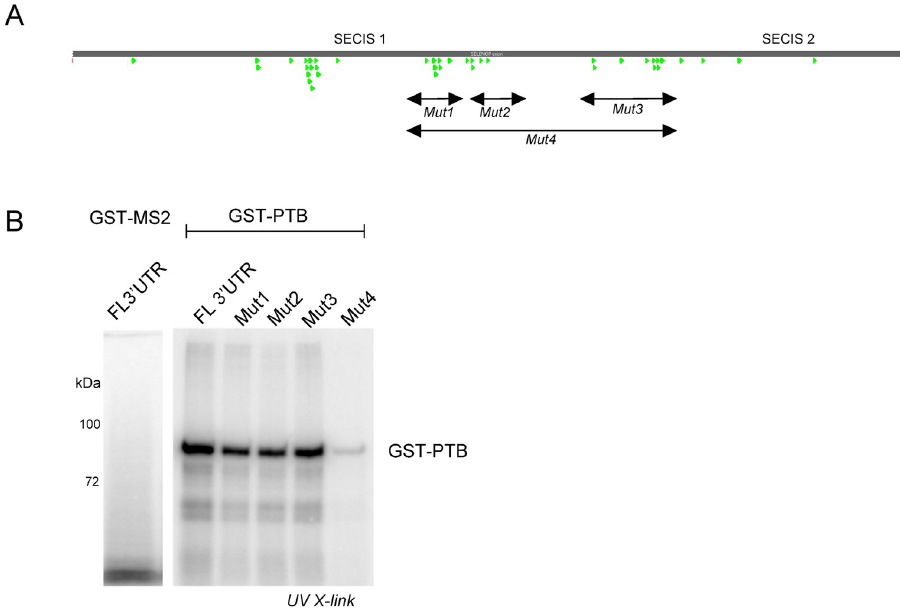
Fig 3. Recombinant PTBP1 binds directly to the SELENOP 3’ UTR. A) Line diagram of the SELENOP 3’ UTR with canonical U-rich PTBP1 binding sites (UCUU) annotated as green arrows. The four regions that were mutated are indicated with arrows. B) SDS PAGE of recombinant GST-PTBP1 protein UV-crosslinked to 32 P-UTP labeled RNA fragments as indicated in A). As a negative control, GST-MS2 coat protein was used as indicated.